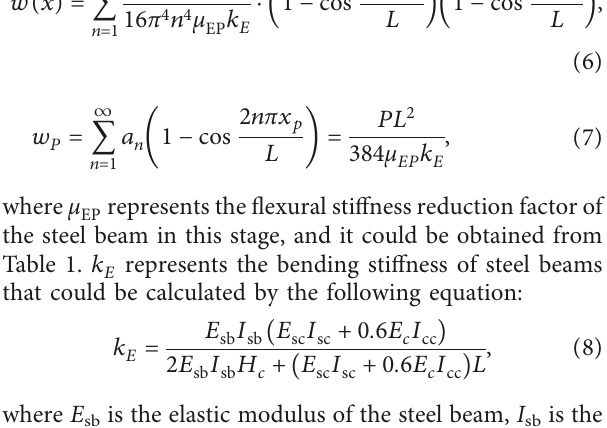
Figure 8: Analysis model in the plastic